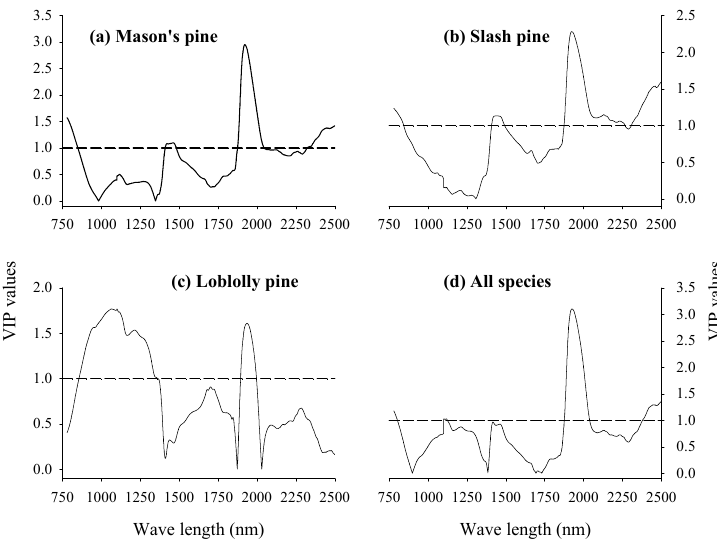
Figure 5. VIP plots depicting absorption bands that were responsible for discriminating viable and dead-filled seeds of Mason’s pine ( a ), Slash pine ( b ), loblolly pine ( c ) and all species combined ( d ).